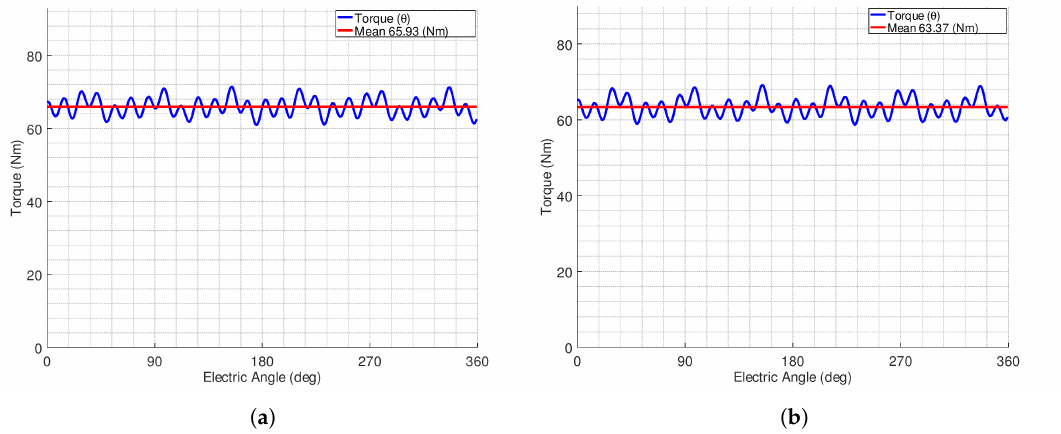
Figure 9. Torque profiles with current ripple of 4 kHz: ( a ) reference SPM; ( b ) proposed IPM.